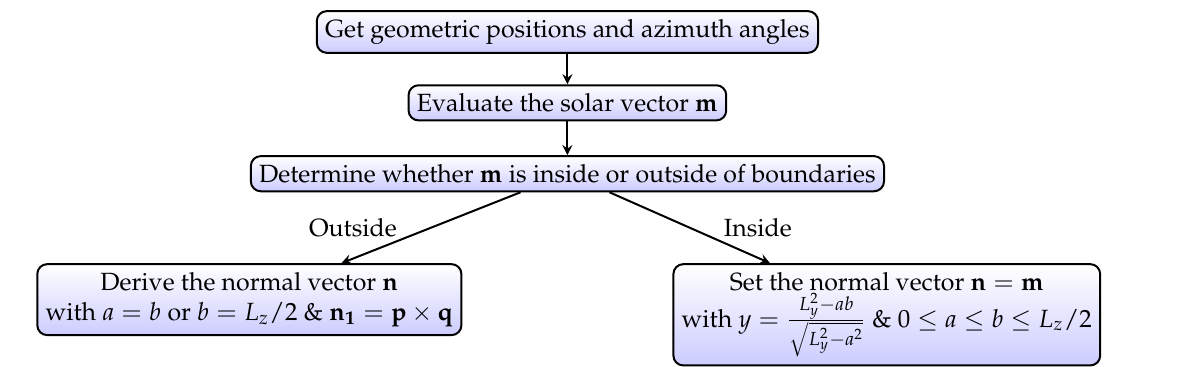
Figure 5. Schematic illustration to find the optimal installation specification of solar panels.